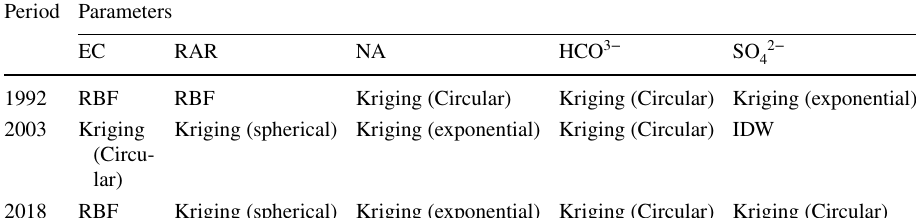
Table 3 Standards of quality for drinking water, according to Schuler (mgL . l )